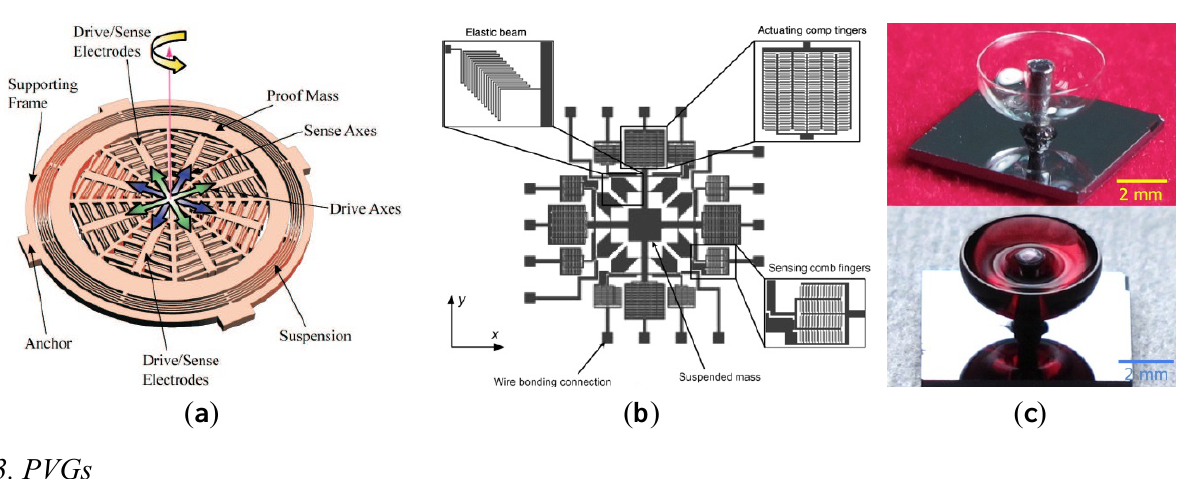
Figure 10. Various angle gyroscopes. ( a ) UC Irvine. ( b ) University of Minnesota. ( c ) University of Michigan.